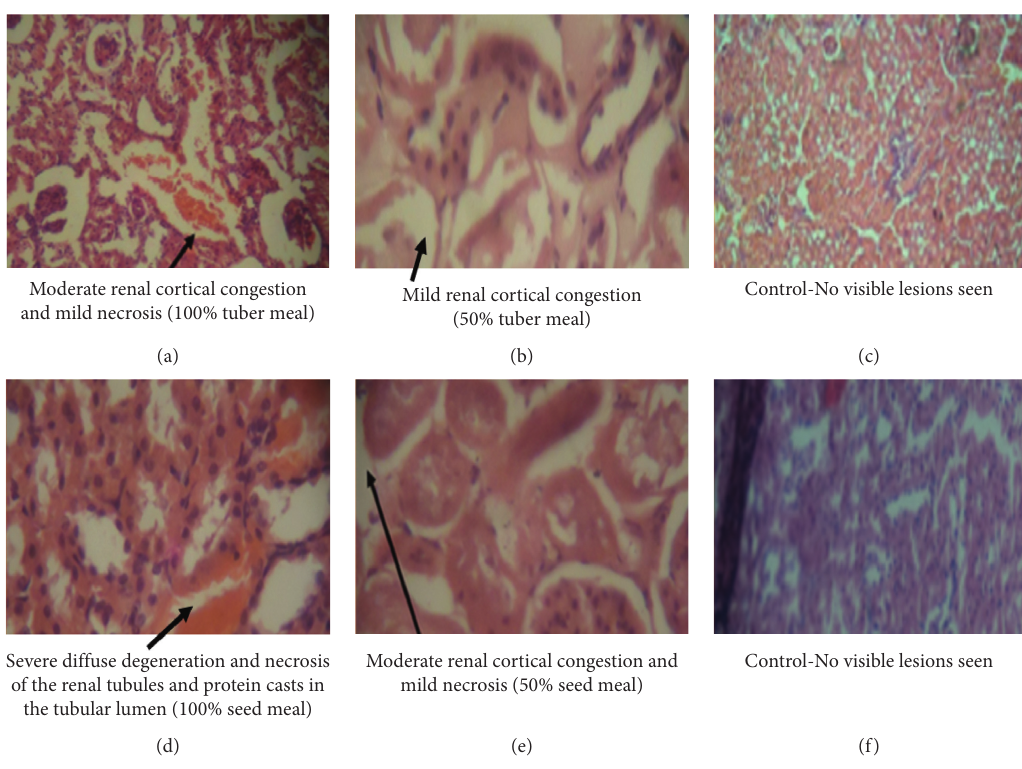
Figure 1: Effect of (a) 100% tuber meal, (b) 50% tuber meal, (d) 100% seed meal, and (e) 50% seed meal, on the kidney of Wistar albino rats. (c and f) Rat chow (control) original magnification ×